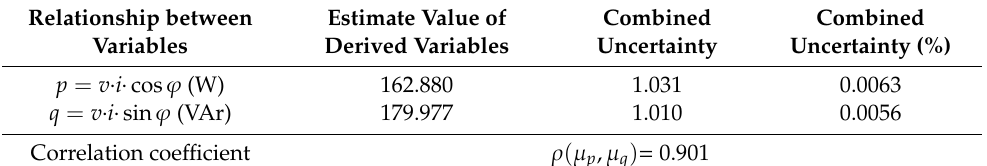
Table 17. Derived variables and calculated values for derived quantities p and q .